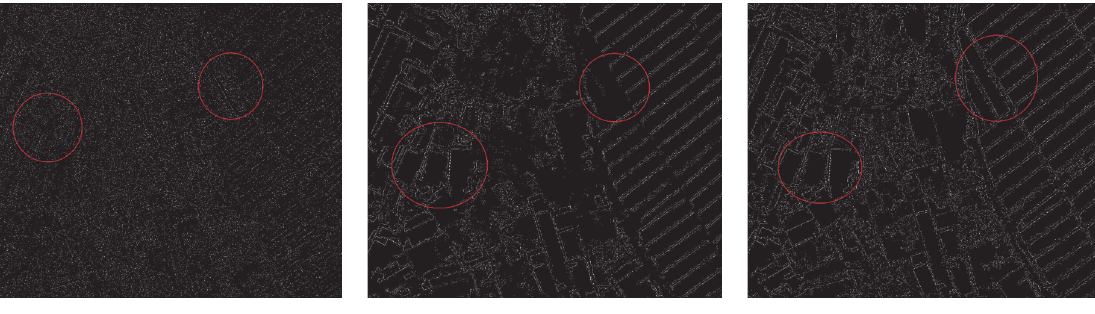
Figure 4: The results of first experiment for Data 1.